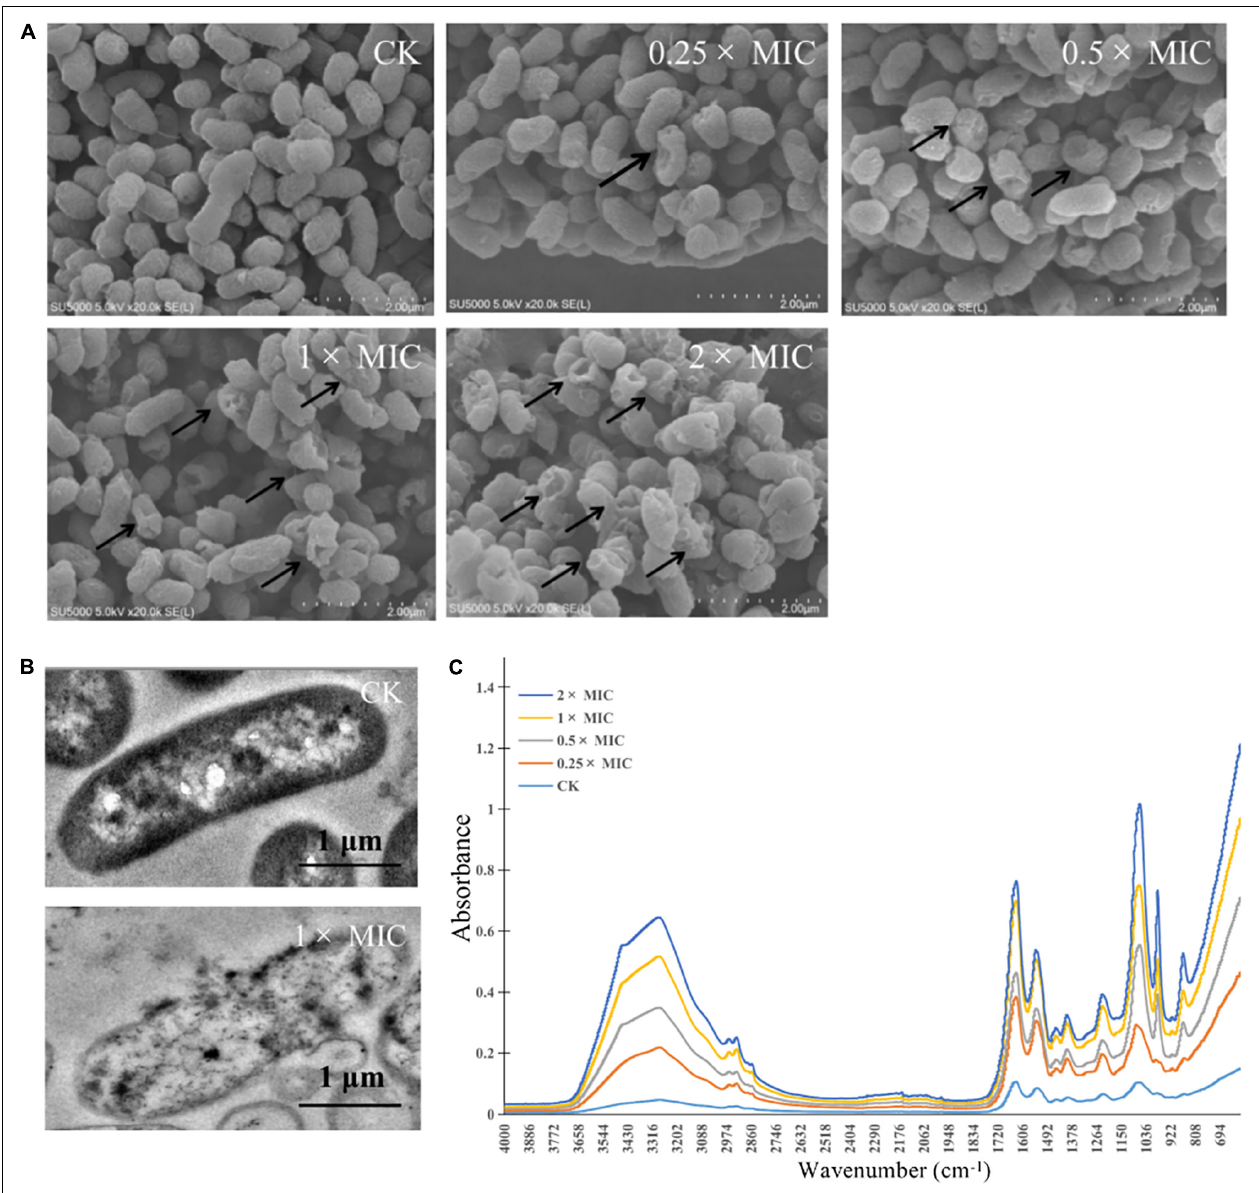
FIGURE 3 | Effects of Melissa officinalis L. essential oil on V. parahaemolyticus shown in SEM [ (A) The magnification is 50,000 × ], TEM (B) images, and the FTIR spectroscopy (C) . CK is the V. parahaemolyticus without Melissa officinalis L. essential oil treated.